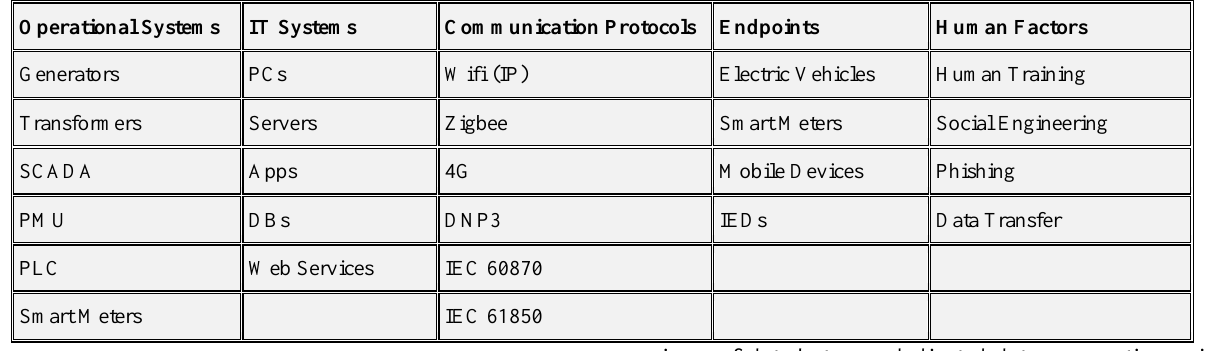
Table 3: Vulnerable Grid Entities [2, 31, 42,